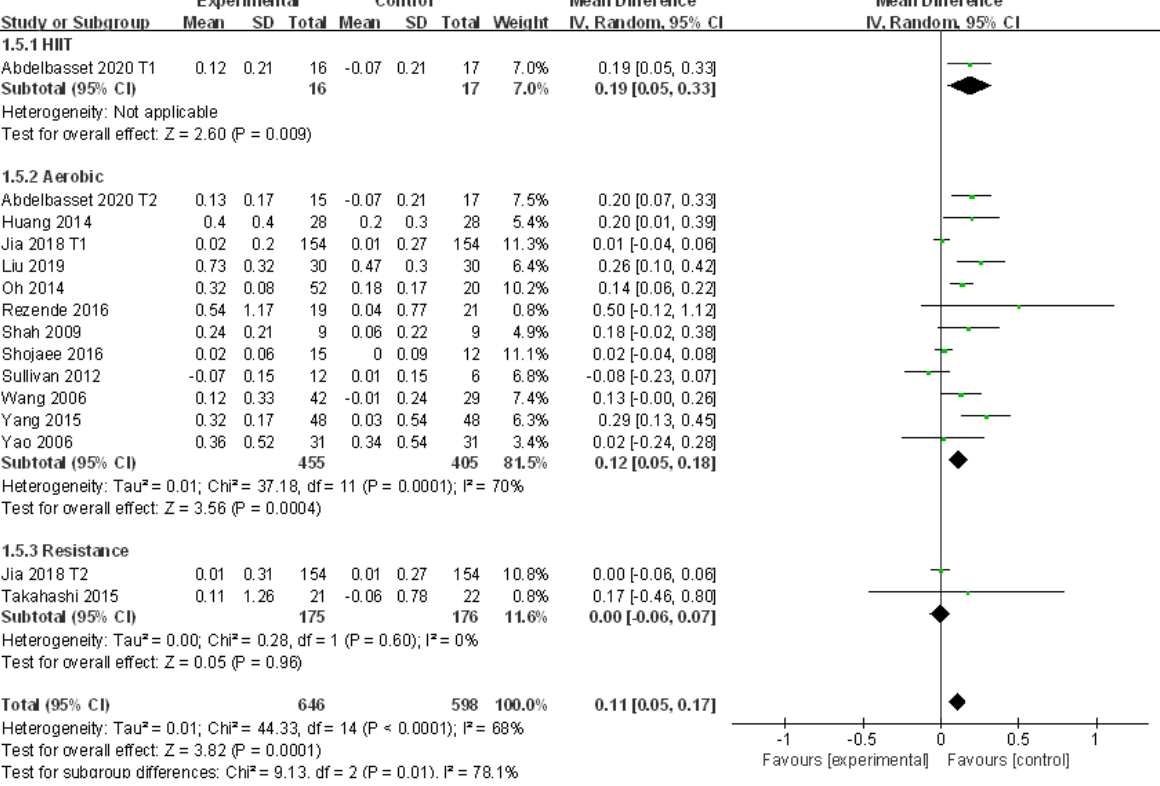
Figure 6. Subgroup analysis of different exercise styles on high density lipoprotein (HDL).